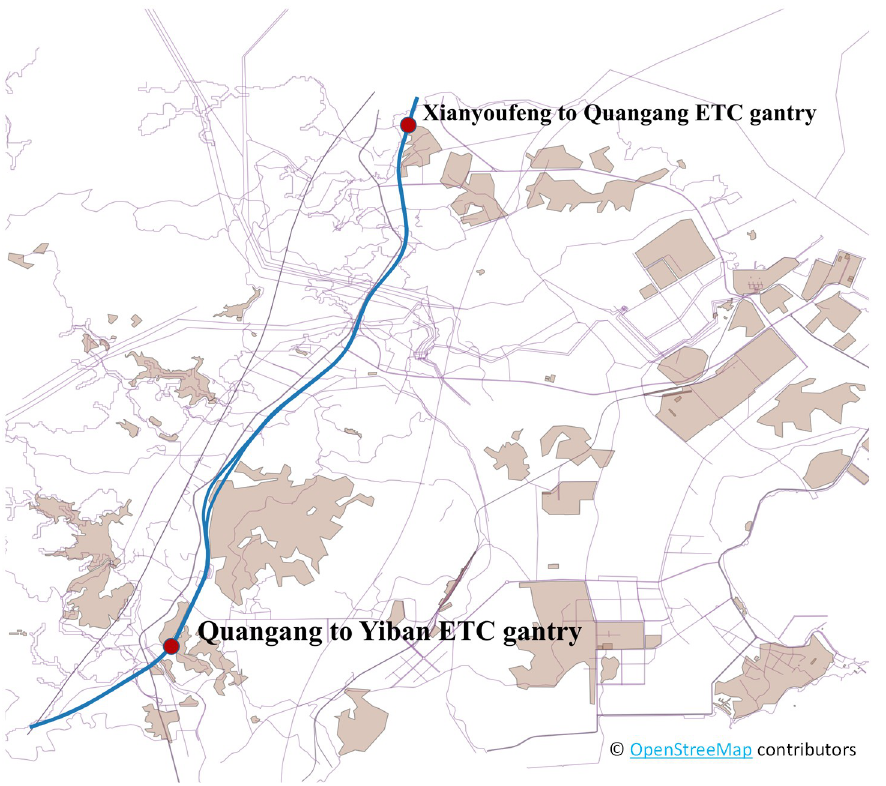
Fig 4. Illustration of the case study